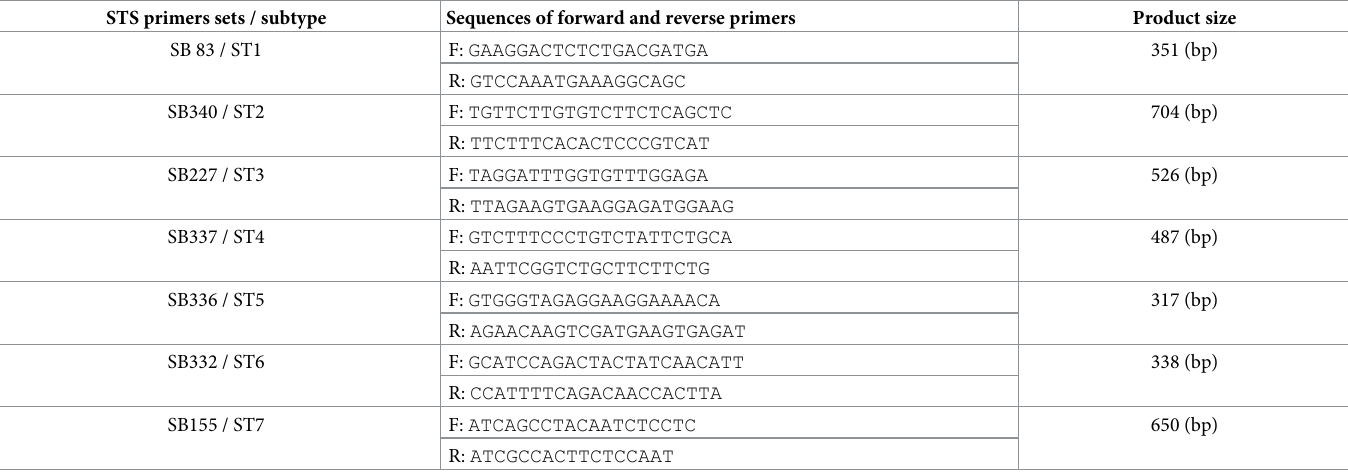
Table 1. The primer sets used for